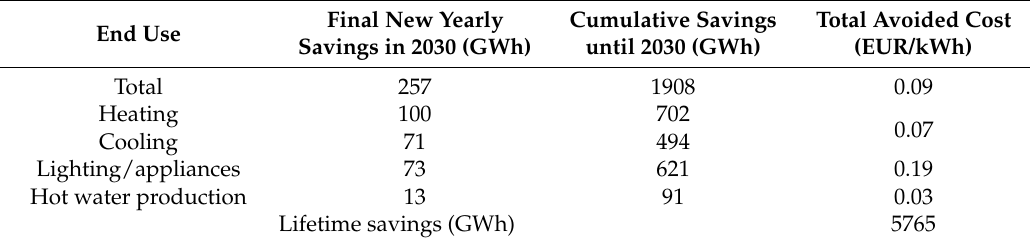
Table 9. Cumulative energy savings in residential buildings of Cyprus according to the recommended allocation of energy efficiency allocation of energy efficiency measures.